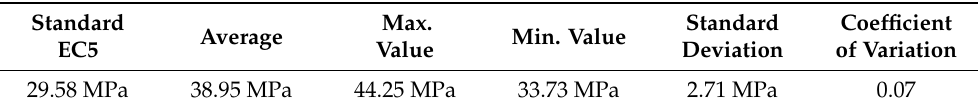
Table 2. Results of the laboratory tests for the determination of hole wall strength and compressibility characteristics for dowel fasteners.